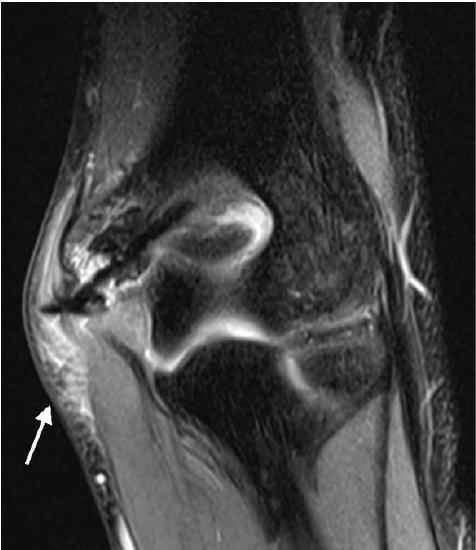
Figure 5. PD tse fs (proton density turbo spin echo fat-saturated) coronal image of the left elbow of a 10-year-old boy with a lateral condyle fracture showing hyperintense soft tissue edema (arrow). Joint effusion: Joint effusion was defined as increased intra-articular fluid, with the distinction between a normal amount of joint fluid and a pathological effusion being subjective, or if the anterior or posterior fat pads were raised in the case of elbow fractures [35] (Figure 6A,B).